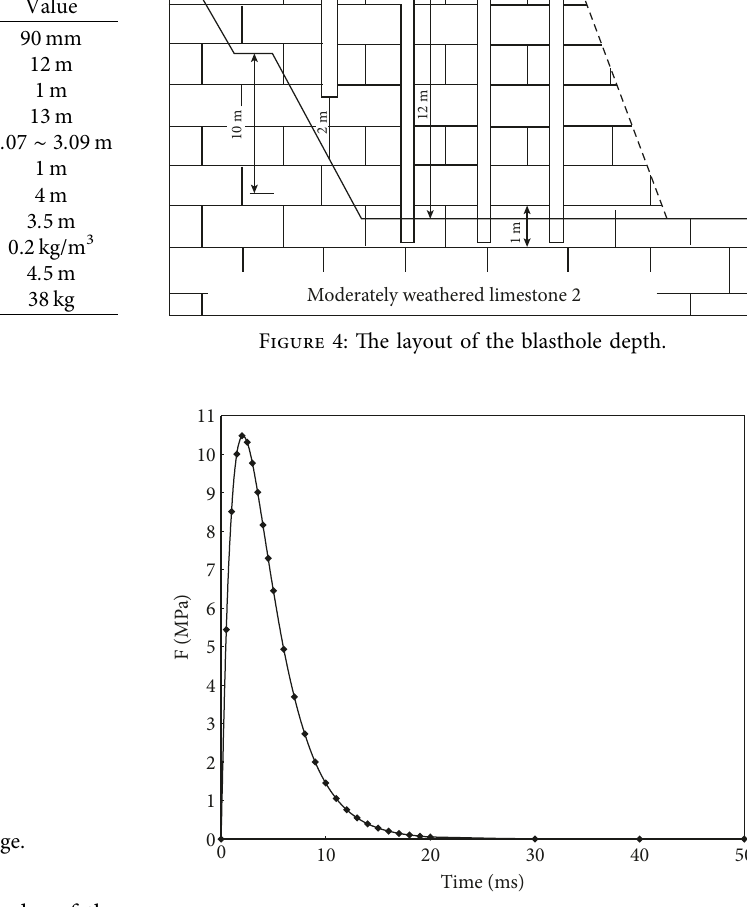
Figure 5: Equivalent dynamic blast load time-history